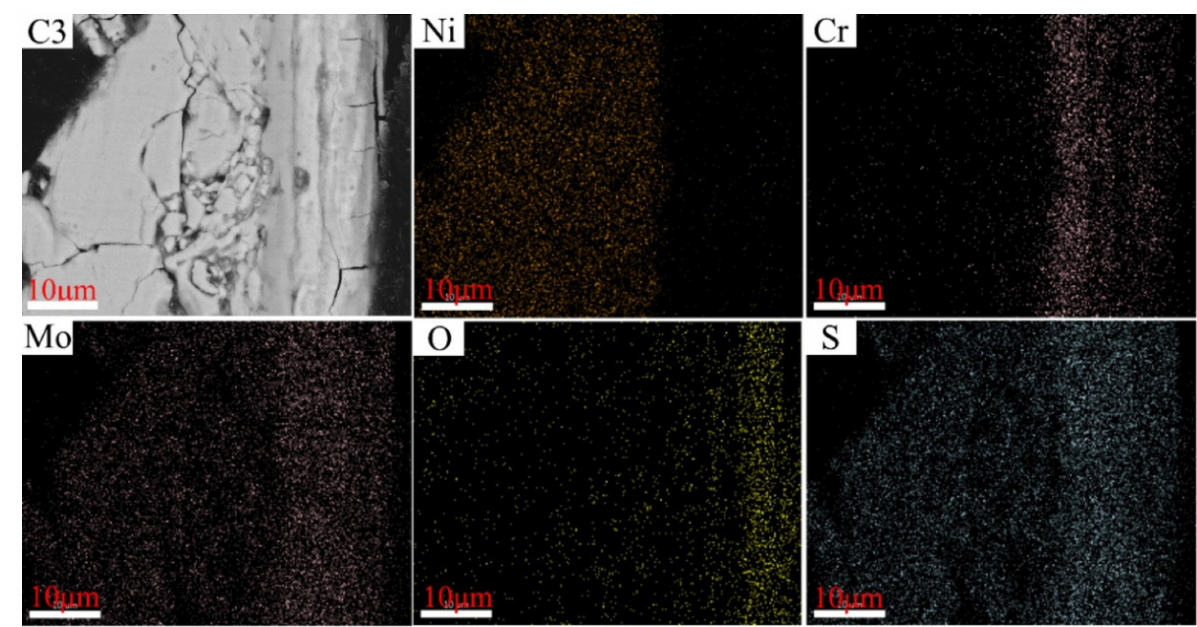
Figure 14. EDS maps for C3 cross-section after the sulfur corrosion test at 550 ◦ C for 168 h.